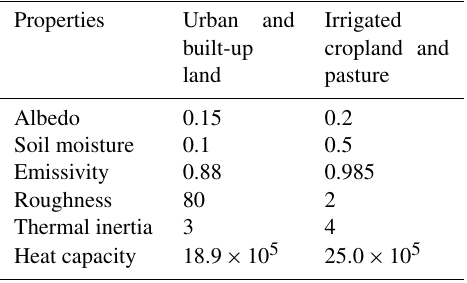
Table 2. Distinctive differences of surface parameters between ur- ban and rural land cover.